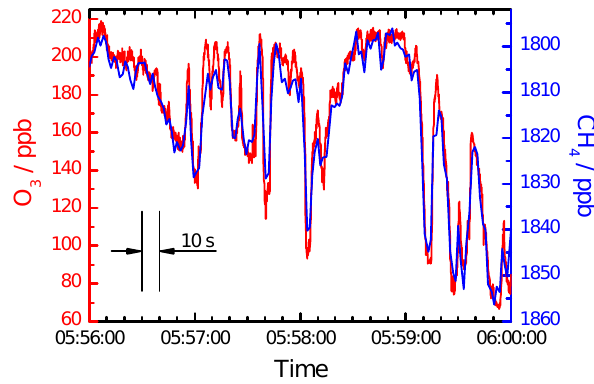
Fig. 10. Small-scale filamentary structures of CH 4 (blue, 1Hz) and O 3 (red, 5Hz) observed during a time period of 4min (60km flight distance) around the tropopause during a flight from Caracas to Frankfurt on 18 September 2013. Note the inverted scale of CH 4 .